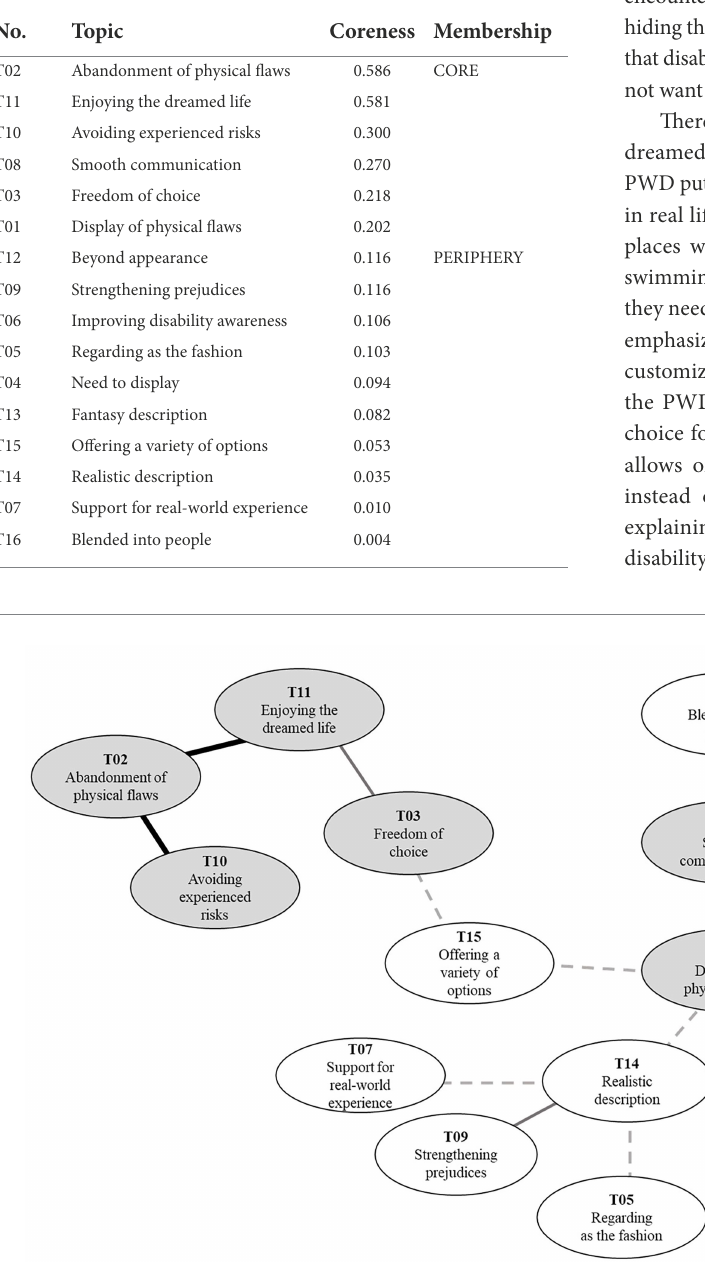
FIGURE 2 Social representations